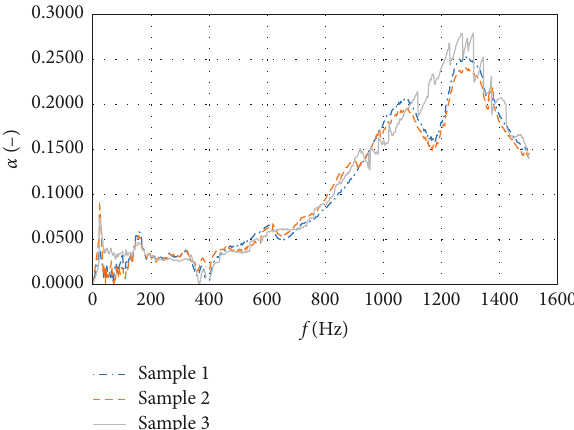
Figure 12: Experimental comparison of the cement plaster samples (sample 3 nonideal circularity).